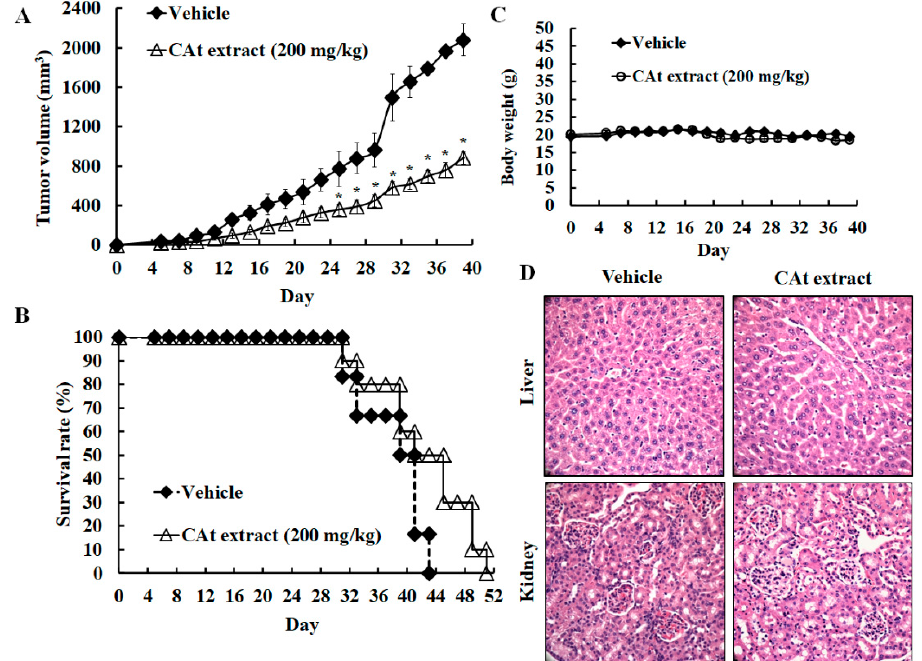
Figure 5. The xenograft tumor model of HCC treated with the CAt extract (200 mg / kg). The tumor suppression ( A ) and the survival rate ( B ) of HCC tumor growth after CAt extract treatment. *: A significant difference between control and treatment, p < 0.05. Evaluation of systemic toxicity of CAt extract administration on the HCC xenograft. The body weight after CAt extract treatment ( C ). The hematoxylin/eosin (H&E) staining of the liver and kidney ( D ).